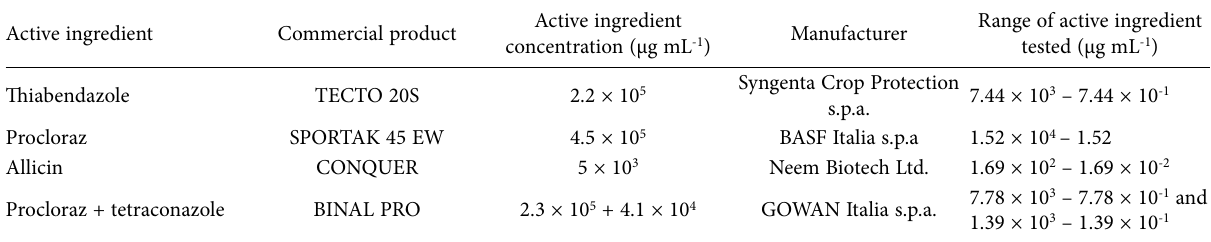
Table 1. Commercial products, active ingredients, and concentrations tested for their fungicidal effects on colony growth of Geosmithia morbida